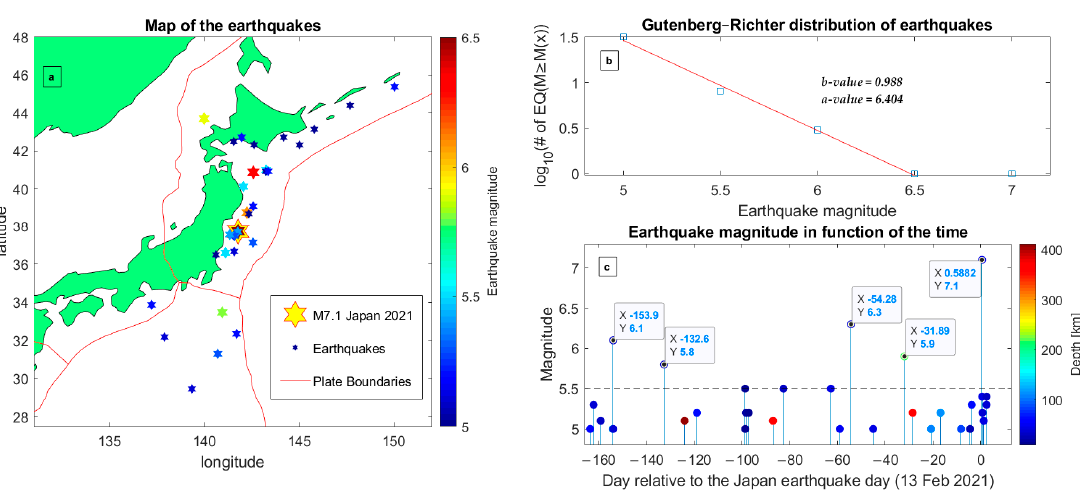
Figure 1. M5+ earthquakes localised by the USGS (https://earthquake.usgs.gov/earthquakes ac- cessed on 21 March 2022) in the Dobrovolsky area for the M7.1 13 February 2021 Japan event. ( a ) Map of the events. ( b ) Gutenberg–Richter distribution of the earthquakes (their number is represented by “#”). ( c ) Magnitude as a function of the time with an indication of the depth by the colour bar. The events with M > 5.5 are highlighted by labels with indications of days with respect to the Japan earthquake (negative days if occurring before the mainshock and positive if occurring after) and their